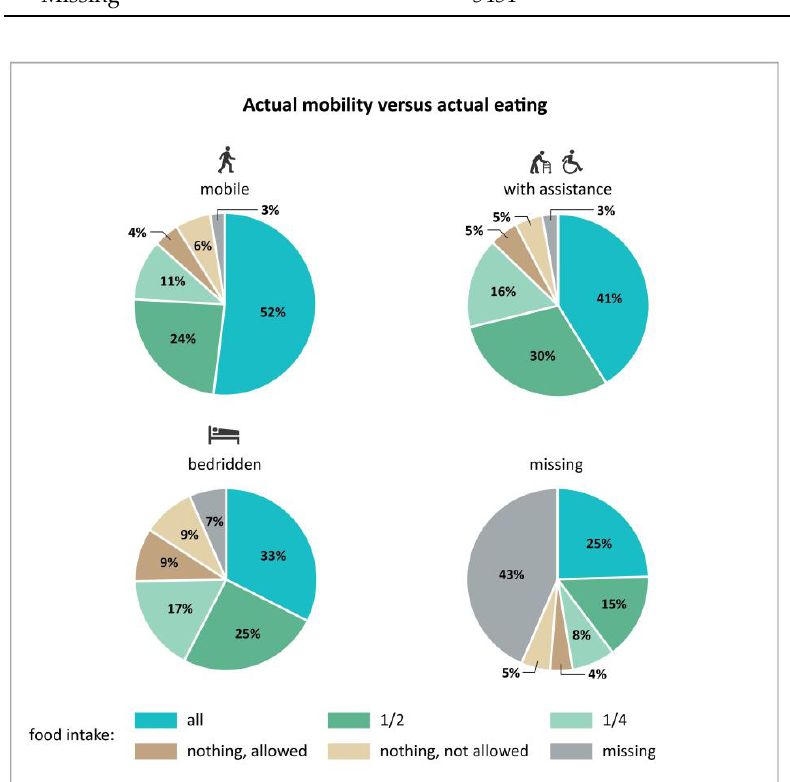
Figure 3. Association between actual mobility and actual eating at a major meal ( n = 48,700).